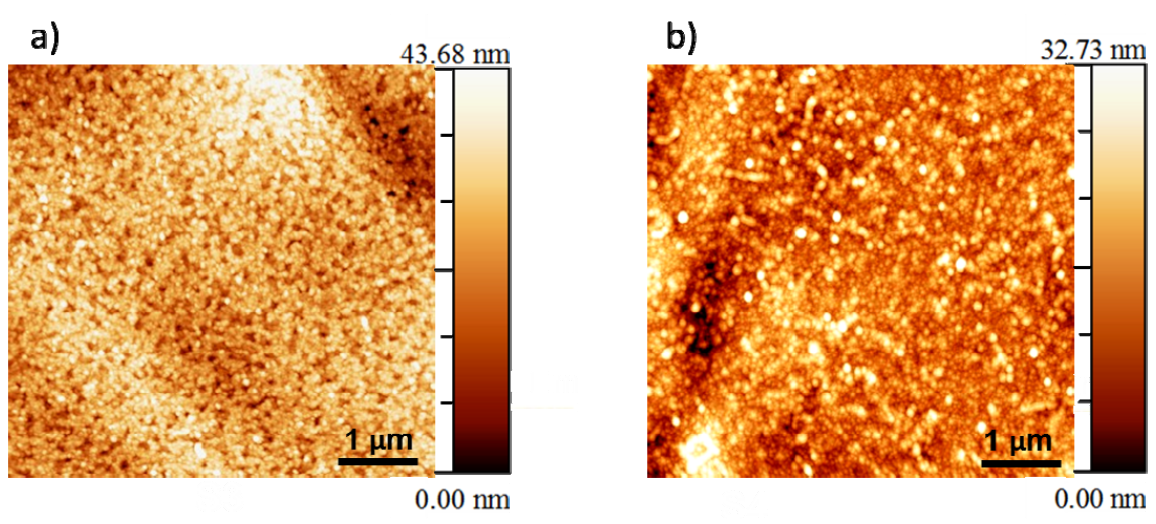
Figure 4. Atomic force microscope (AFM) image of ( a ) La Zr O on Ni-5% W ( b ) La 0.60 0.40 y